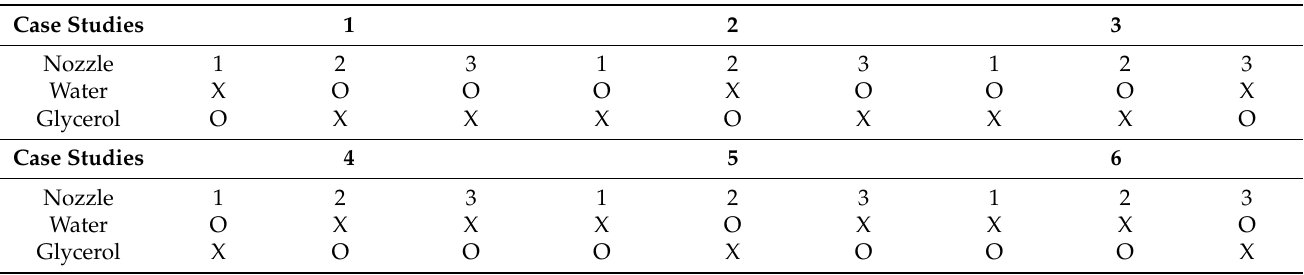
Table 1. Phases injection input scenarios.